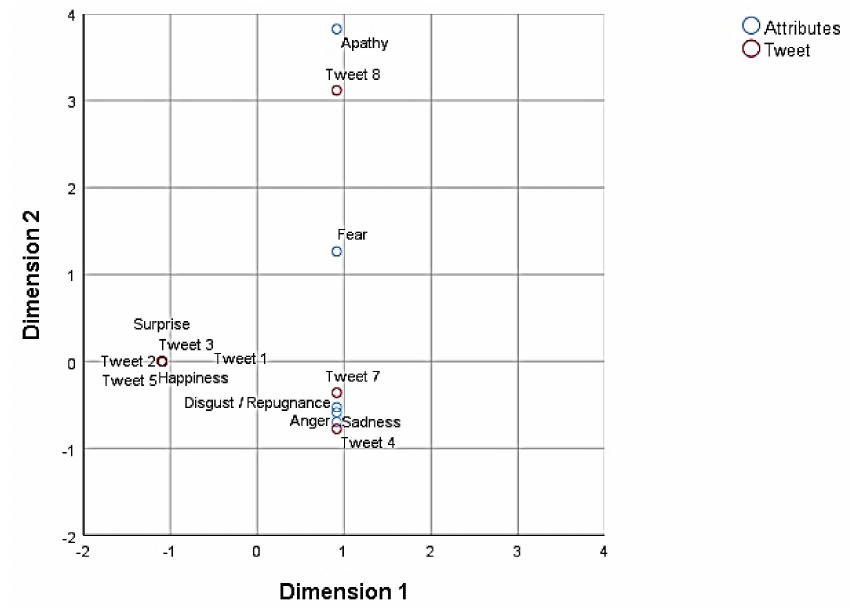
Figure 4. Positions of attributes (emotional variables) and